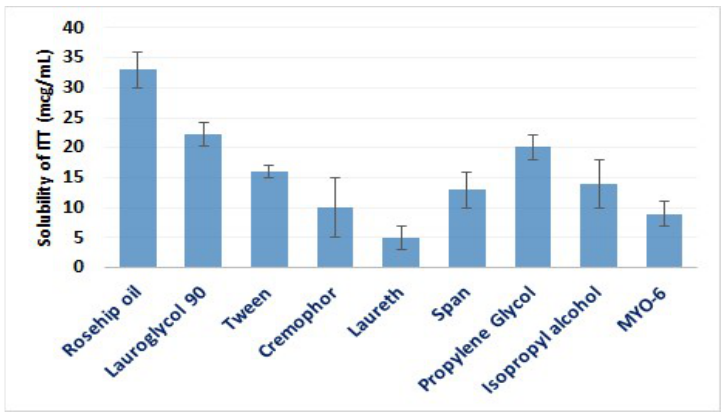
Figure 3. The solubility of ITT in assorted vehicles. Data are presented as mean ± SD ( n = 3).